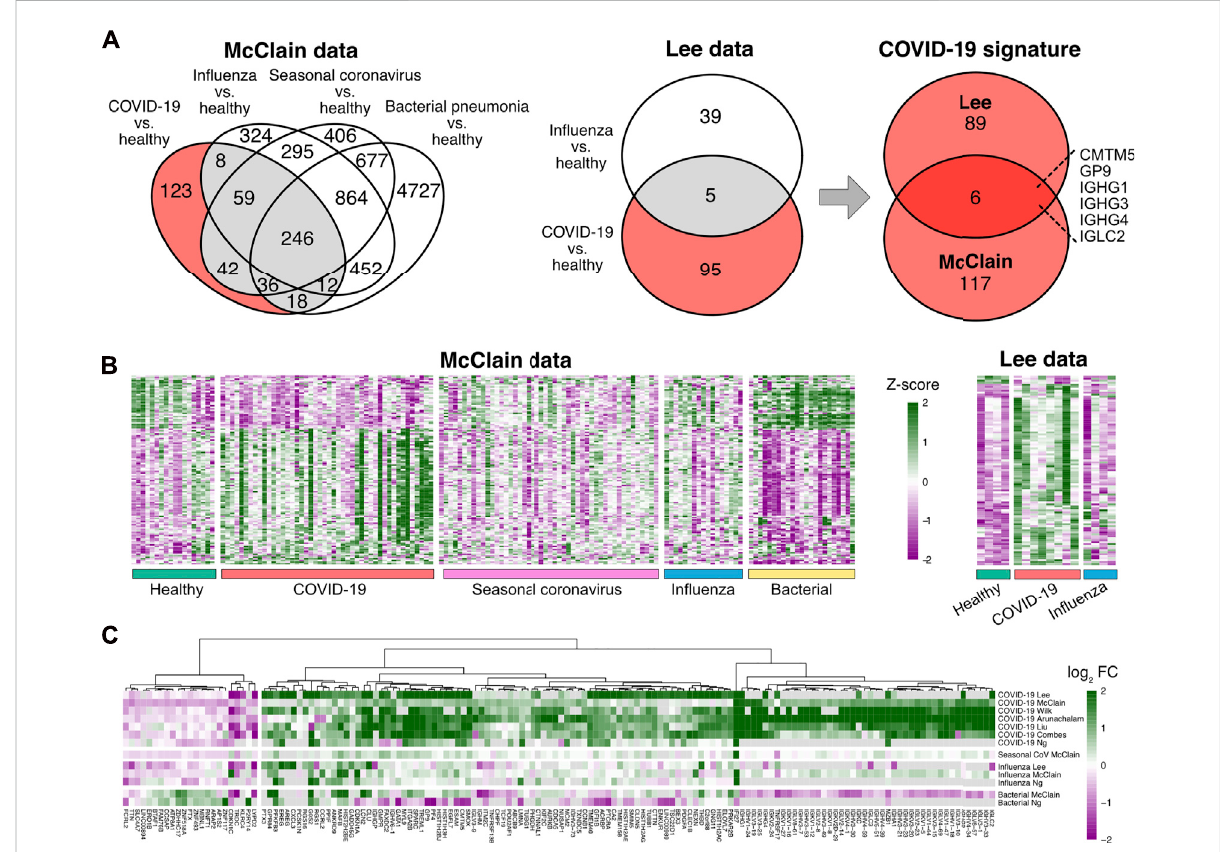
FIGURE 1 Determination of the COVID-19 speci fi c signature (A) Differentially expressed genes in COVID-19 and other infections compared to healthy controls in the McClain and Lee data. Genes that were differentially expressed speci fi cally in the COVID-19 patients compared to healthy controls and notbetweenotherdisease states (in fl uenza, bacterial pneumonia,seasonalcoronavirus) andhealthycontrols are shown with ared background. The Venn diagram on the right shows the number of shared COVID-19 speci fi c differentially expressed genes in the McClain and Lee data. (B) Heatmaps of the expression levels of COVID-19 speci fi c genes detected from the McClain and Lee data. (C) Fold changes of the signature genes in COVID-19 and other infections compared to healthy controls across multiple independent